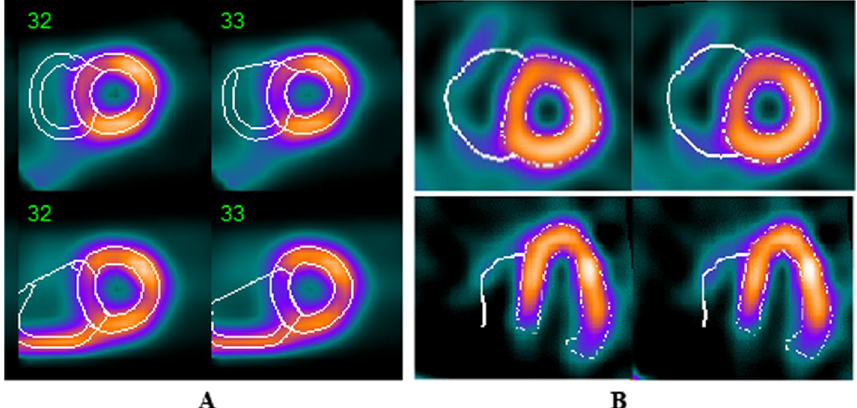
Fig. 13 A QPS results in the absence (first row) and presence (second row) of extracardiac activity— B QCard-NM mis-segmentation in patient with high RV eccentricity index (first row); an example of the valve plane mis-localization in QCard-NM segmentation result (second